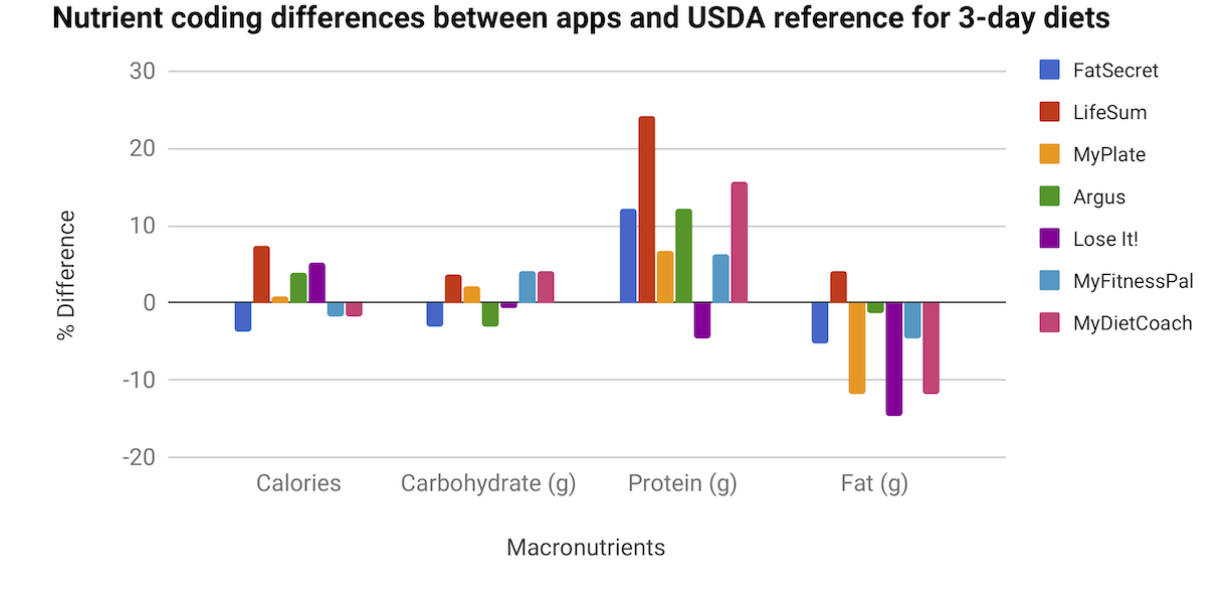
Table 2. Example of nutrient coding differences between apps for 3 food items.